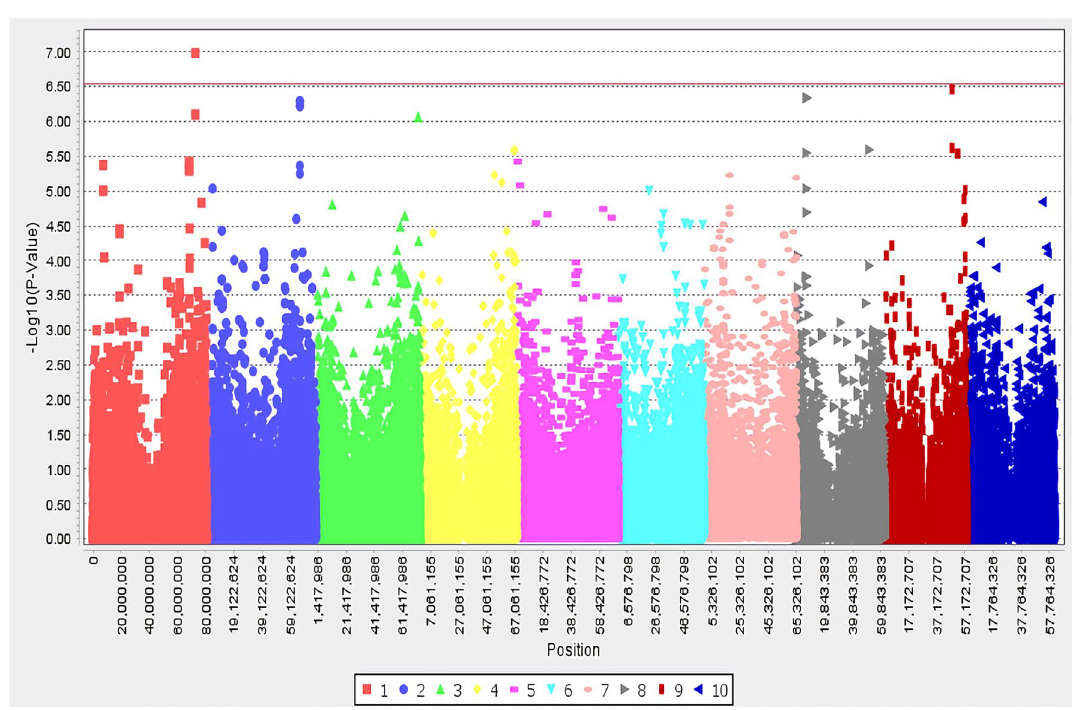
Figure 2. The genome-wide association for response to anthracnose in Senegalese sorghum seedlings. Manhattan plot showing locations of SNP-detected QTLs associated with response to FSP53 on the